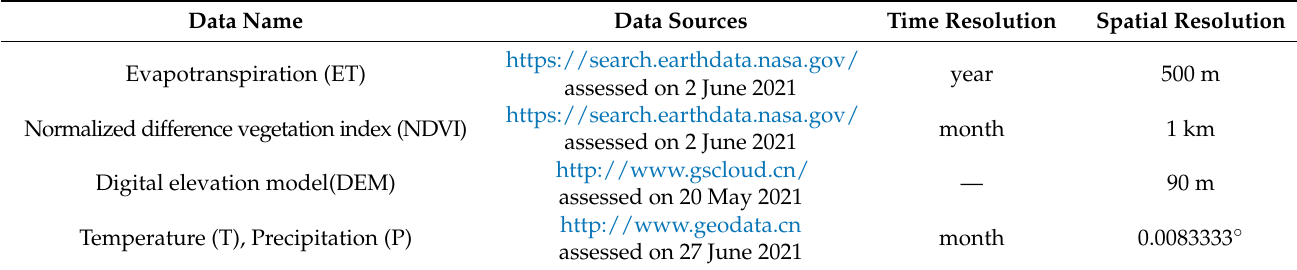
Table 1. Introduction table of research data